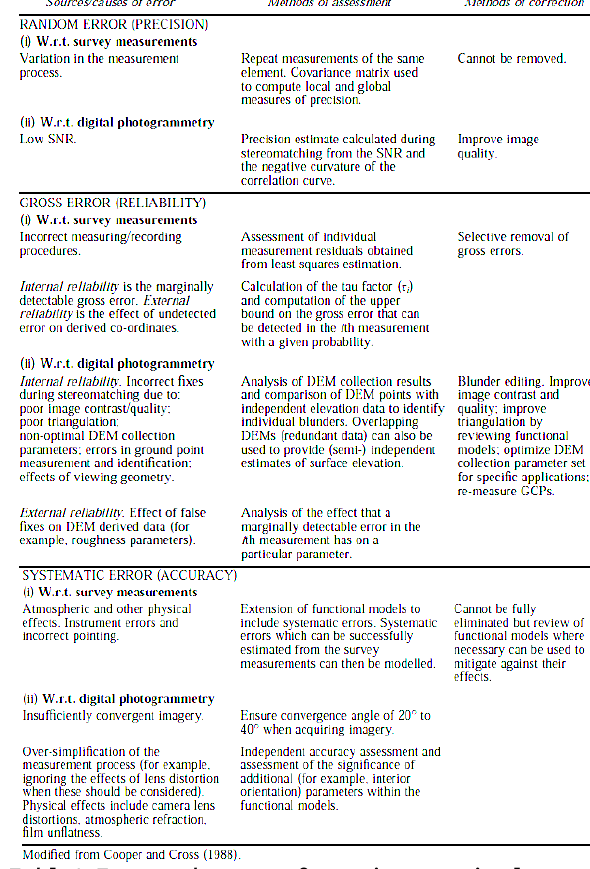
Table 1. Types and sources of error in conventional survey and close range digital